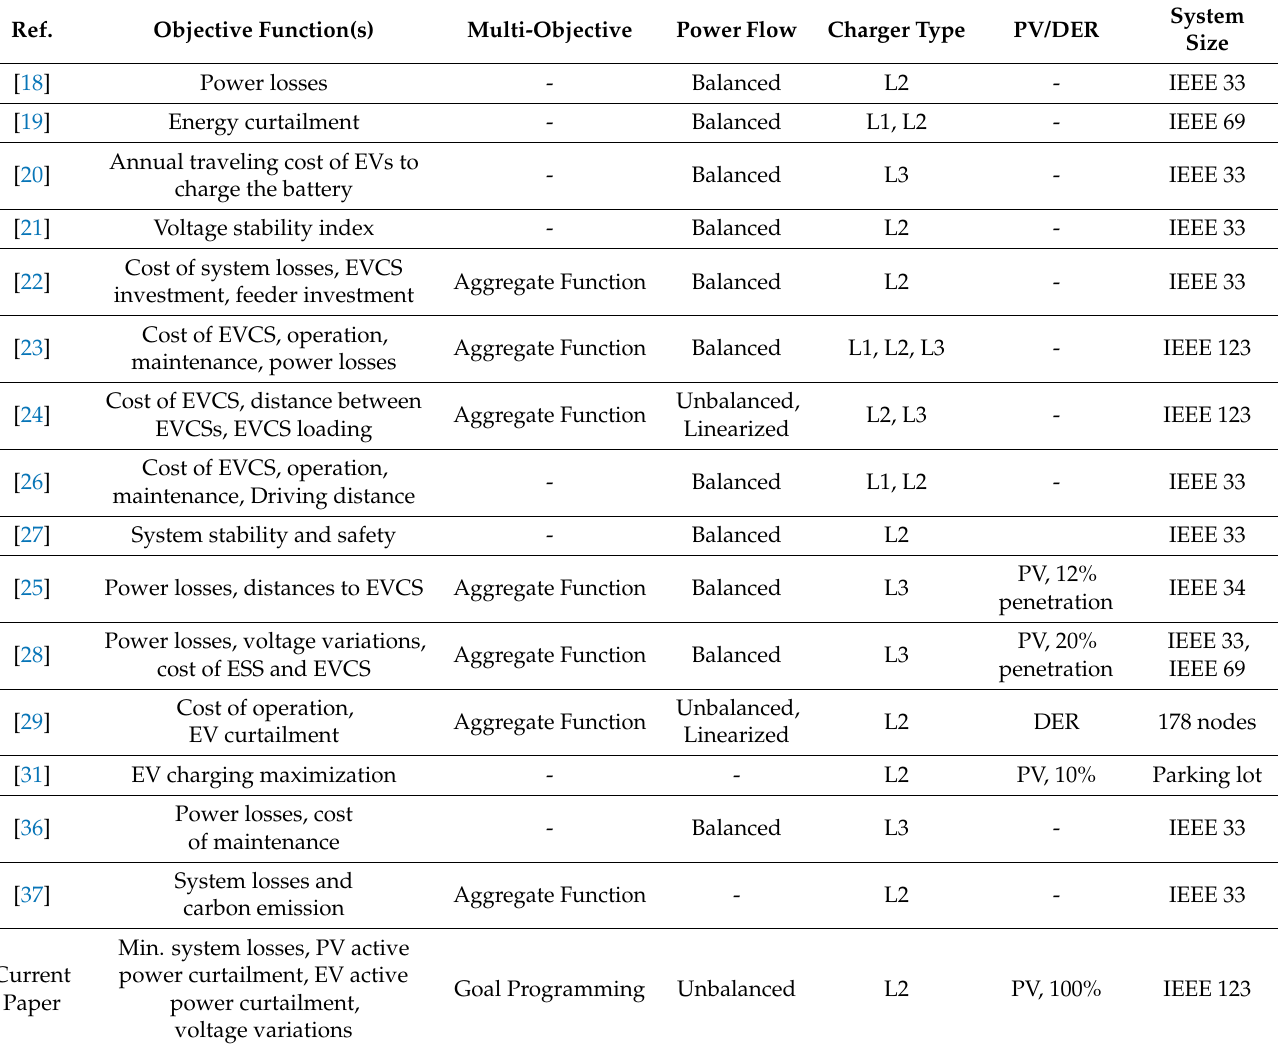
Table 1. Review of the literature related to management and integration of EVs in the power distribution